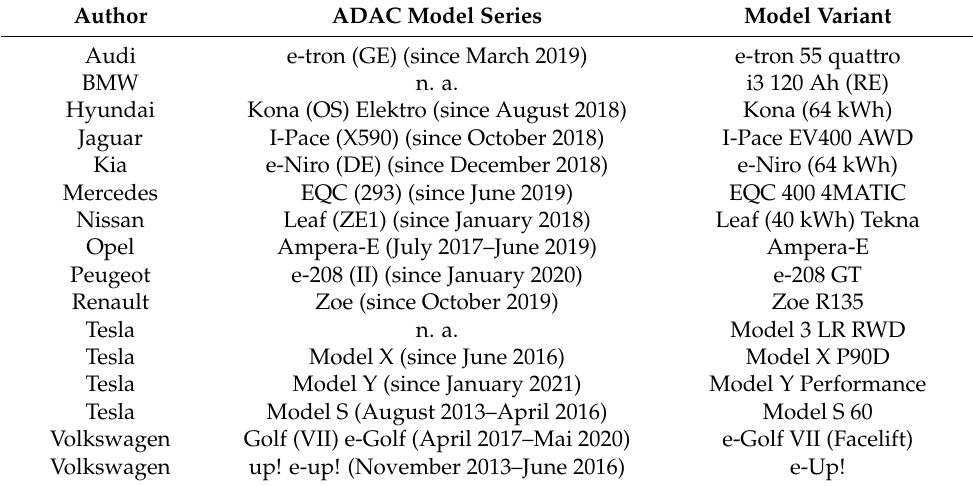
Table 2. Evaluation dataset for the parametric mass